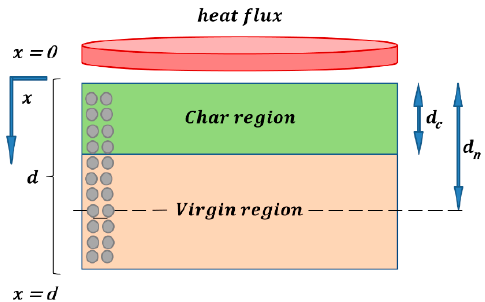
Figure 2. Scheme of the idealized two-layer model for studying the post-combustion mechanical properties of a laminated composite material (for clarity reason, only one part of the fiber is represented).